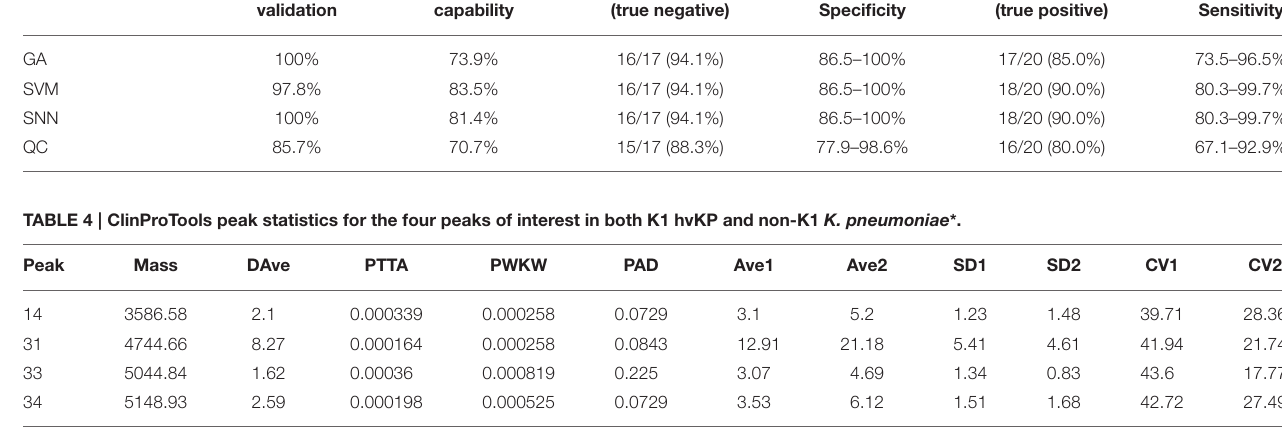
accuracy of K1 and non-K1 identification was 94.1 and